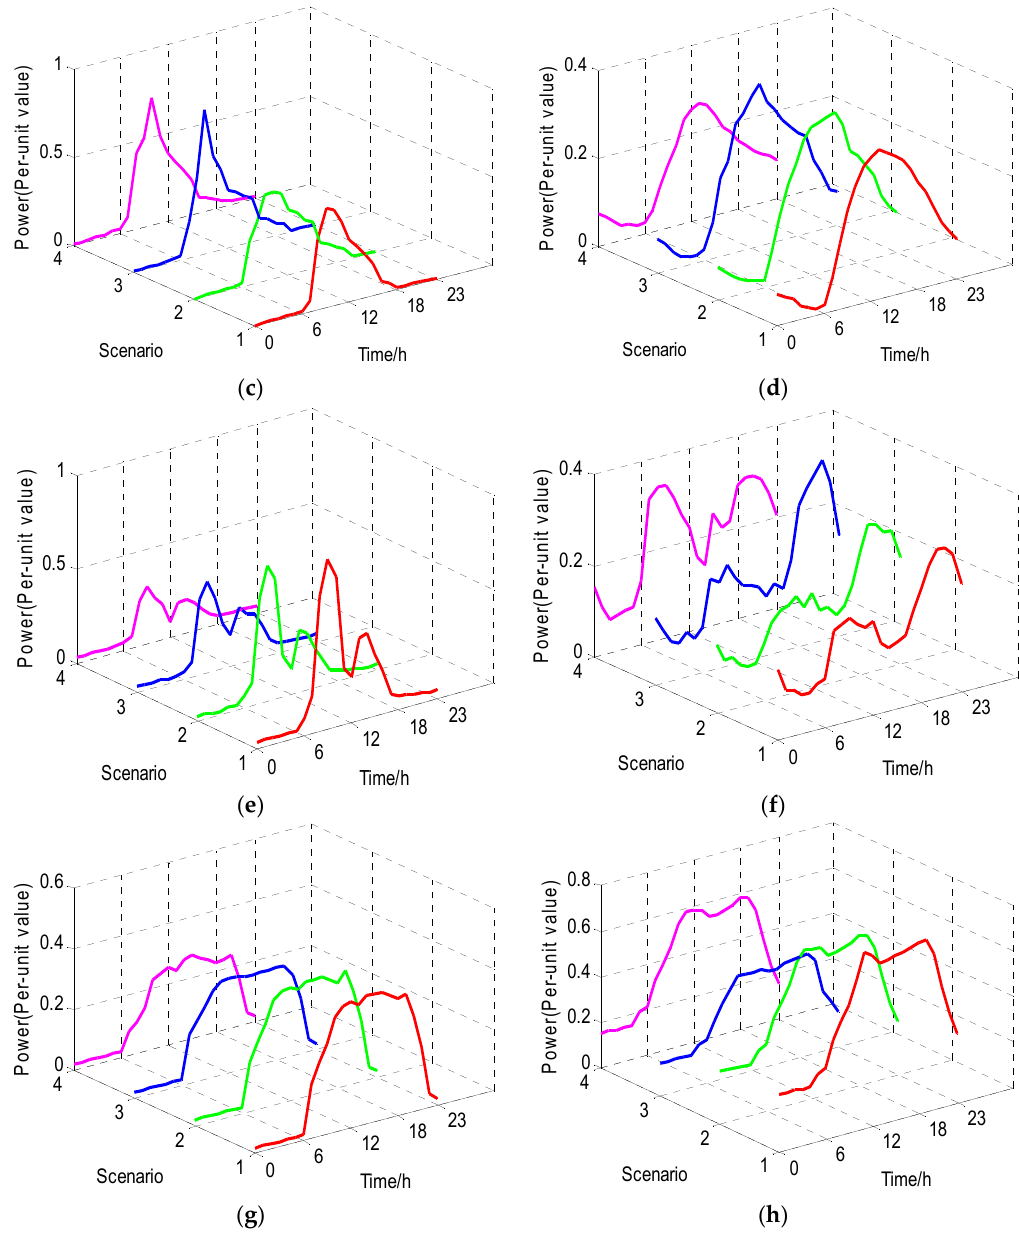
Figure 8. The split scene characteristic curves of each DSR representative user. ( a ) Typical summer scenario of WT; ( b ) Typical summer scenario of photovoltaic power; ( c ) EV charging station of residents area; ( d ) EV charging station of commercial area; ( e ) Machinery industry; ( f ) Residents area load; ( g ) Market; ( h ) Hotel.